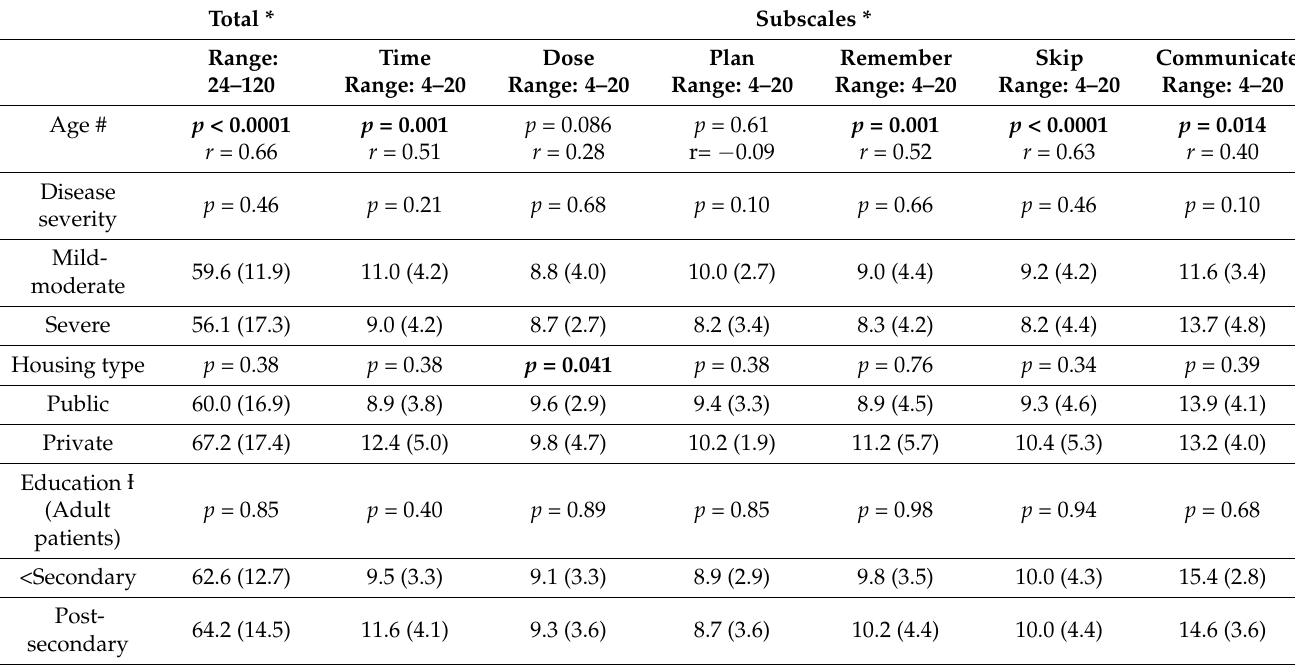
Table 3. Summary and Univariate Comparison of Treatment Adherence across Clinically Relevant Table 2. Summary and Univariate Comparison of Health-related Quality of Life Outcomes across Subgroups among Patients who Received Prophylactic Treatment. Clinically Relevant Subgroups.